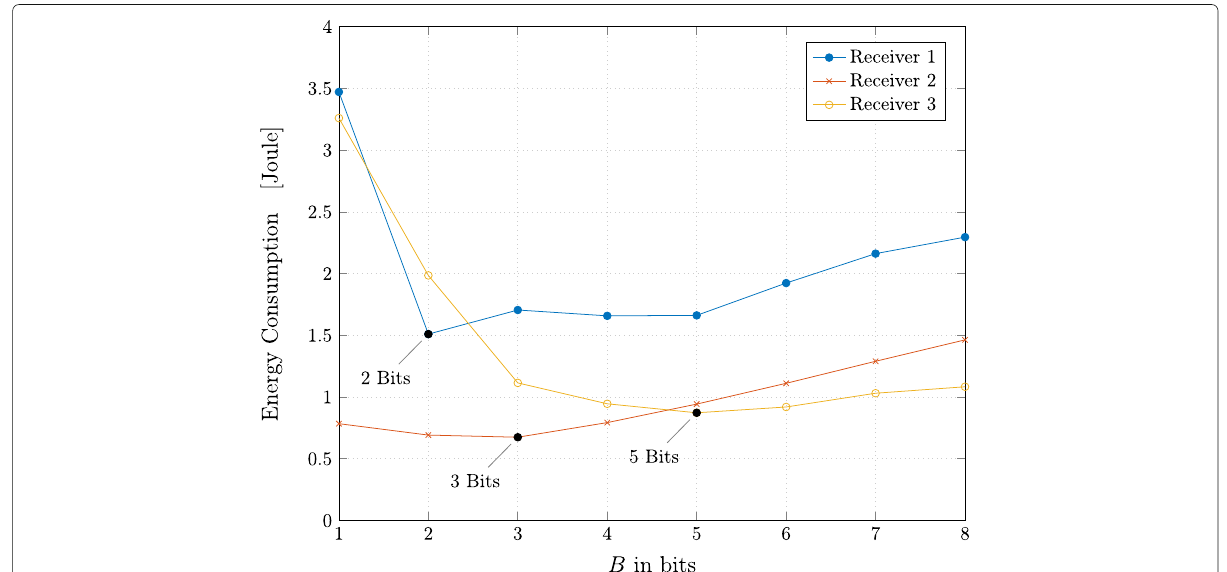
Fig. 6 Energy consumption. Energy consumption of feedback and multicast transmission of four transmitters calculated at three different receivers for different number of quantization bits B . Each receiver chooses B ∗ that minimizes energy consumption